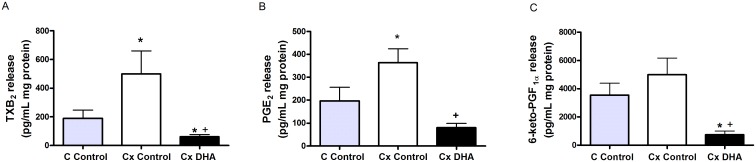
Effect of orchidectomy and DHA supplemented diet on prostanoid basal release in rat mesenteric arteries.Release of thromboxane B2 (TXB2), prostaglandin E2 (PGE2) and PGI2 (panels A-C) in mesenteric artery from control (C) and orchidectomized (Cx) rats fed with a control diet and from Cx rats fed with a DHA-supplemented diet (Cx DHA). Values are means ± SEMs. n = 4–8; *p <0.05 compared to arteries from control group, +p <0.05 compared with arteries from Cx Control group.